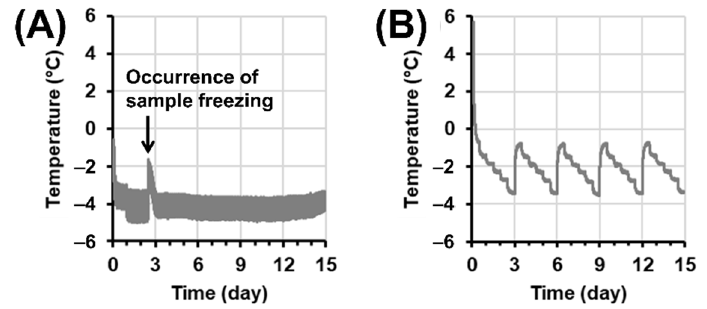
Figure 1. Representative time–temperature profiles of ( A ) superchilling and ( B ) supercooling preservation of beef loins.